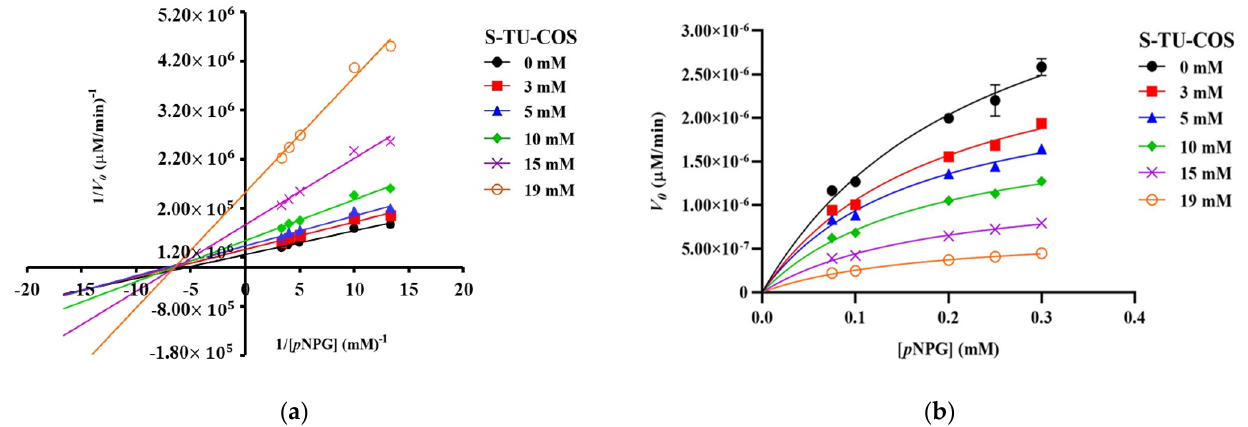
Figure 3. Kinetic analysis of α -glucosidase inhibition. ( a ) Lineweaver–Burk plot and ( b ) Michaelis– Menten plot of the inhibition kinetic by S-TU-COS with different concentrations of p NPG. The values are given as mean ± SD ( n = 3).